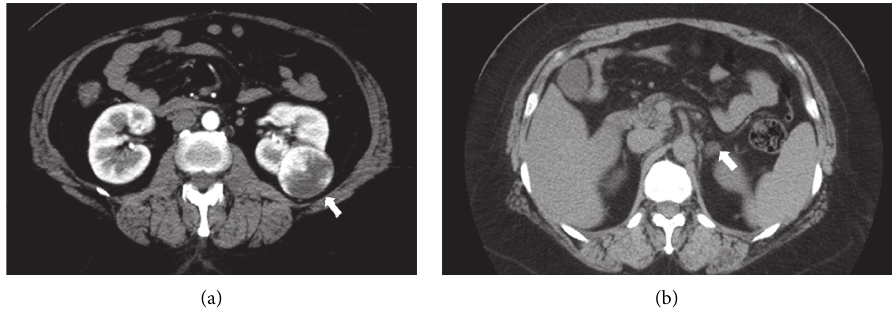
Figure 1: The computed tomographic (CT) findings of the left adrenal tumor. (a) Renal tumor in the arterial phase. Most of the left renal tumor was enhanced using contrast medium, except the necrotic area. (b) Adrenal tumor. The left adrenal tumor was a low-density mass having a diameter of 10mm and was suspected as adrenocortical adenoma.